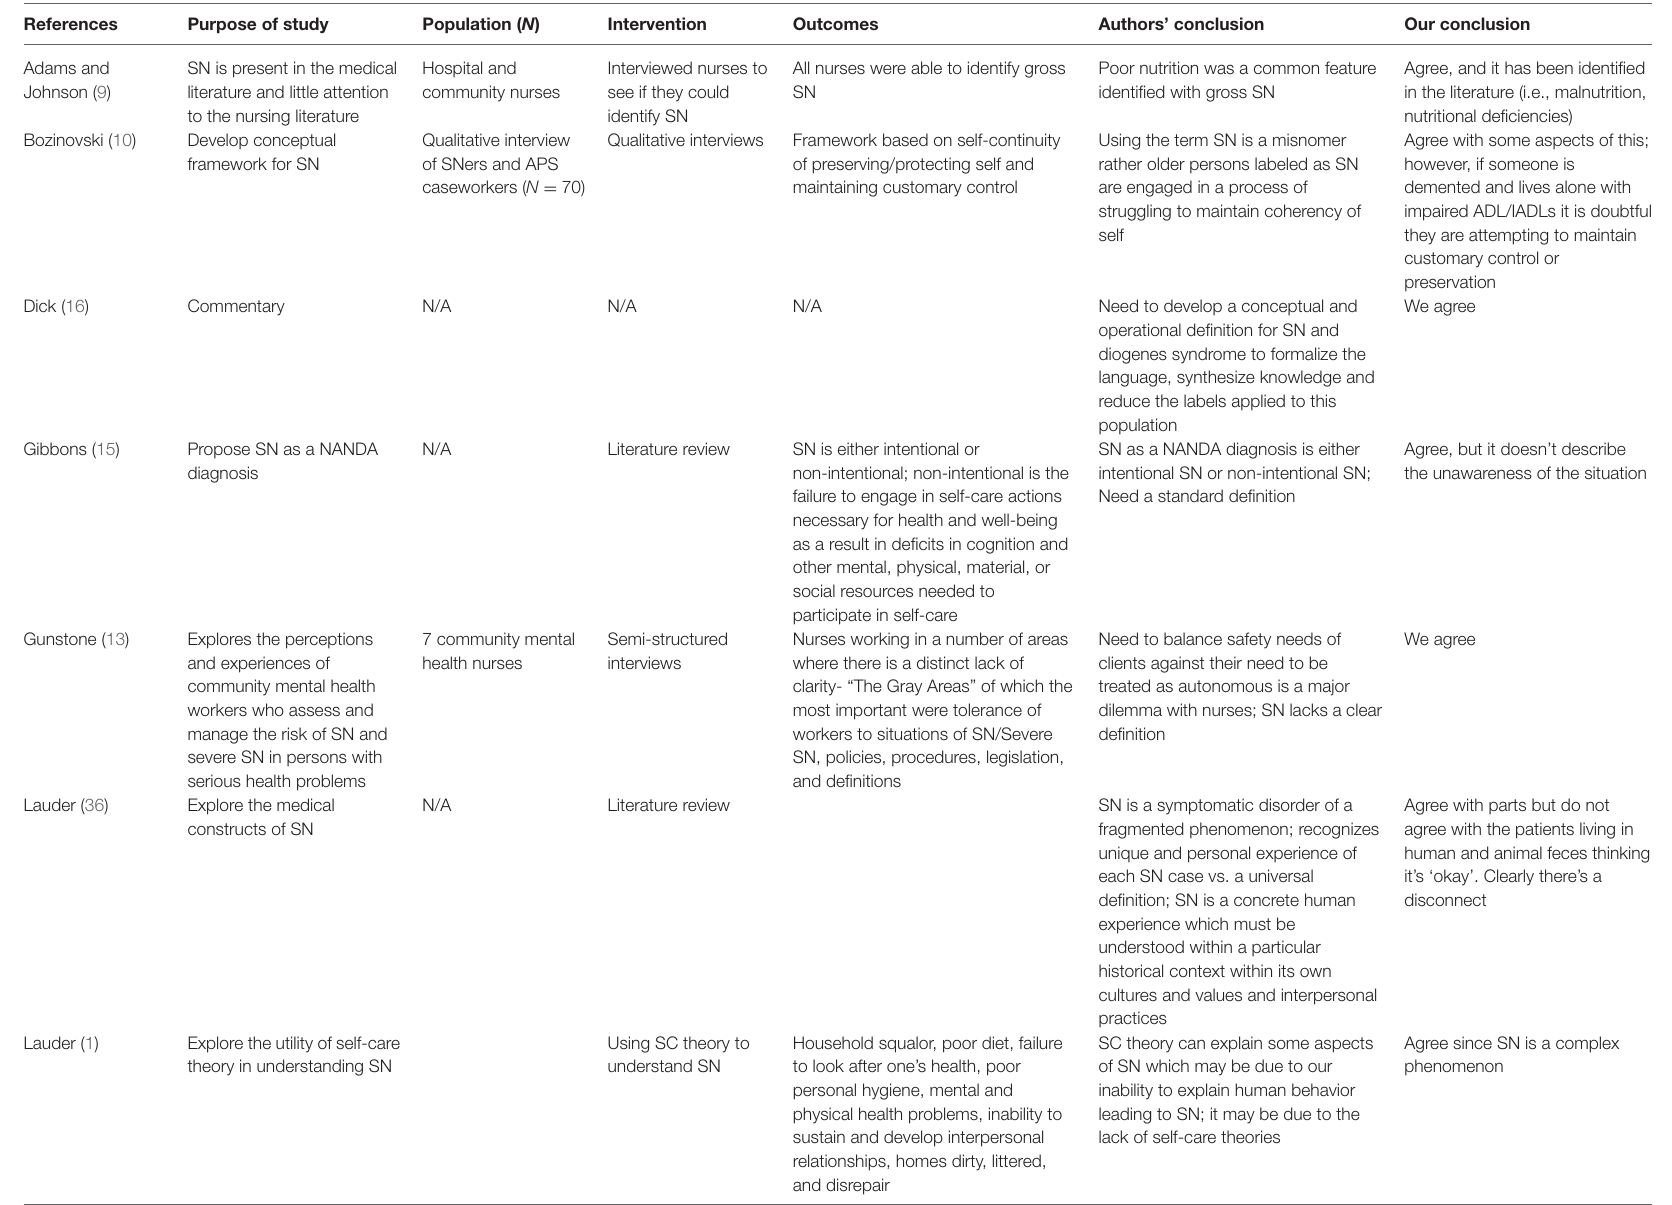
TABLE 1 | Lack of standard definition decreases identification of Self-Neglect